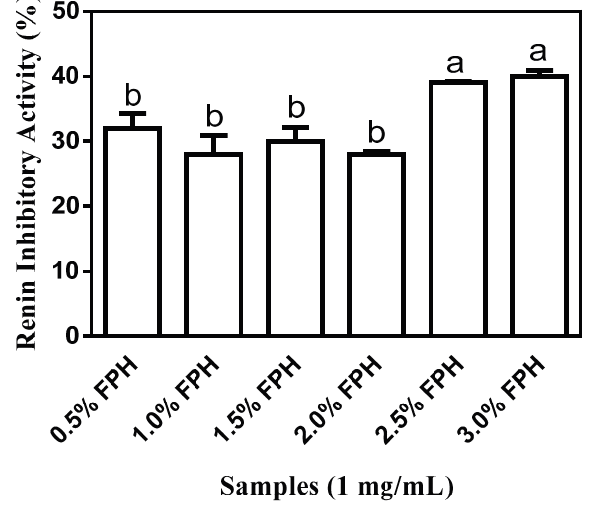
Figure 2. Percentage (mean ± standard error) renin-inhibitory activity of flaxseed protein hydrolysates (FPH) after sample hydrolysis with a range (0.5%–3%) of thermoase GL-30 concentrations. Bars with different letters have mean values that are significantly different ( p <